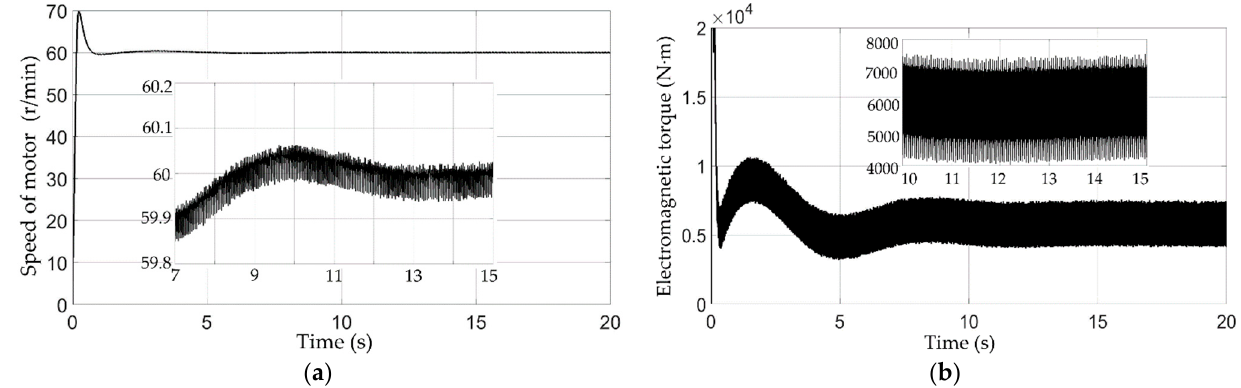
Figure 10. Response curve of driving motor of traditional belt conveyor system under light load. ( a ) Speed curve. ( b ) Electromagnetic torque curve.